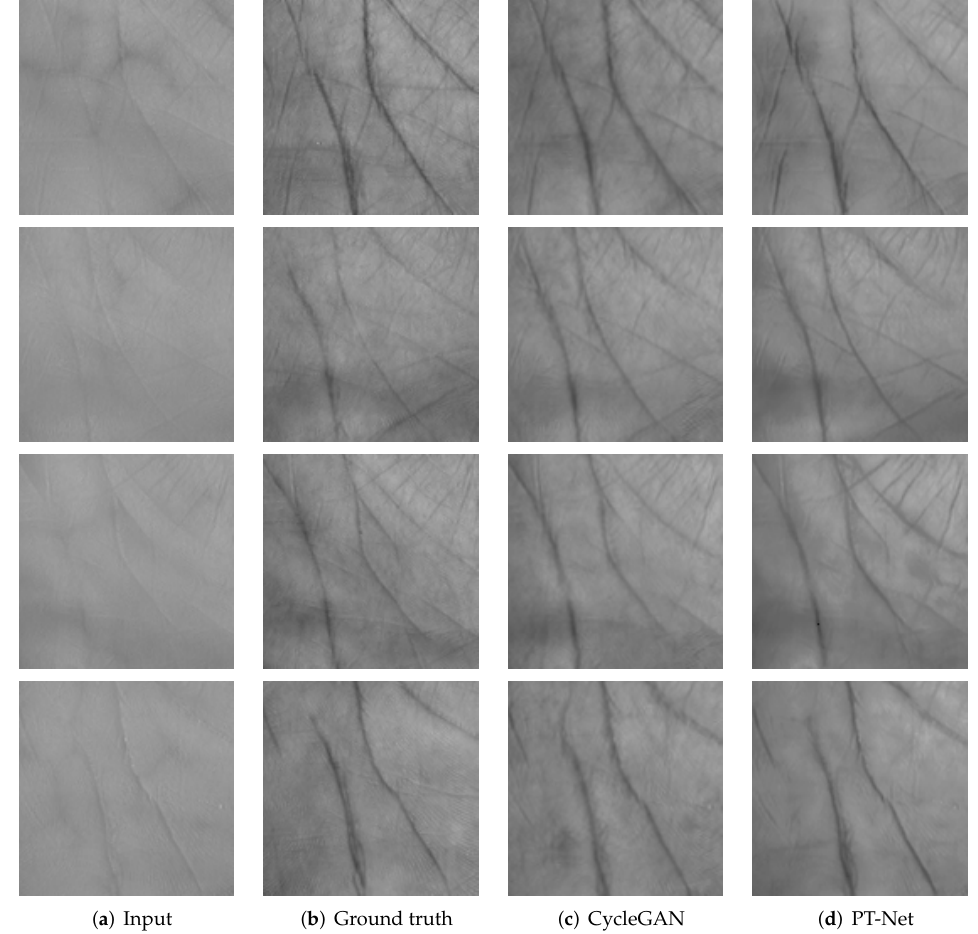
Figure 5. Translation results of CycleGAN and